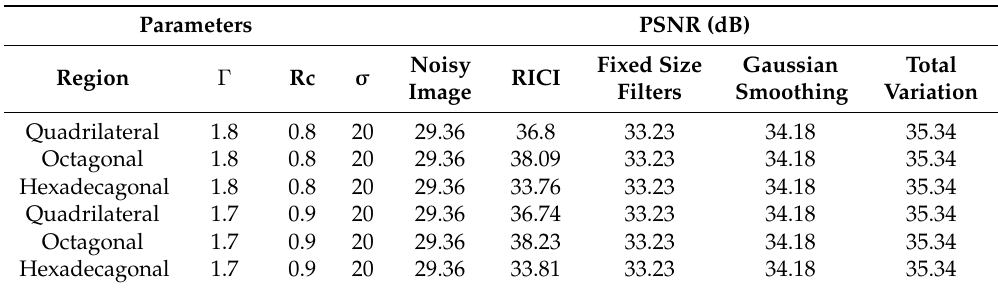
Figure 4. Chest X-ray scan. ( a ) Original noise-free image; ( b ) Noisy image (AWGN with σ = 25); ( c ) Image denoised using the 2D LPA-RICI method (quadrilateral region, Г = 1.8, Rc = 0.8); ( d ) Image denoised using the 2D LPA-RICI method (octagonal region, Г = 1.8, Rc = 0.8); ( e ) Image denoised using the 2D LPA-RICI method (hexadecagonal region, Г = 1.8, Rc = 0.8); ( f ) Image denoised using Gaussian smoothing filters; ( g ) Image denoised using total variation denoising. Table 3. PSNRs for chest X-ray images denoised using the proposed 2D LPA-RICI method and the competitive methods.